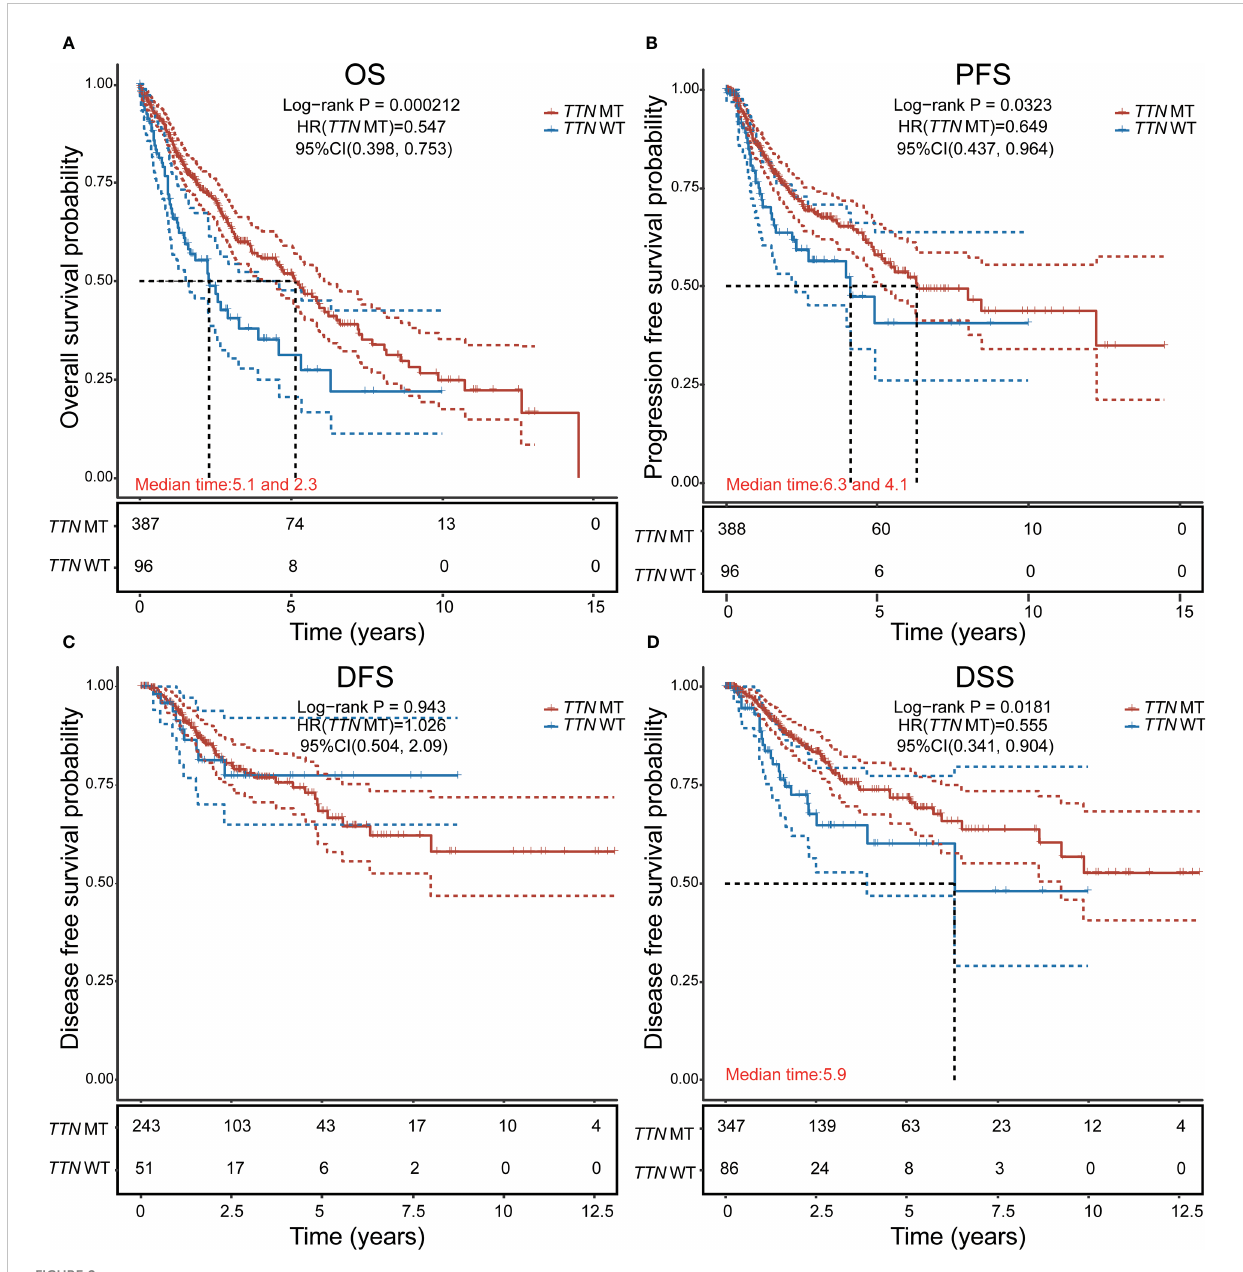
FIGURE 2 Analysis of the effect of TTN mutation on prognostic survival in LUSC using the Cox regression model. (A) Overall survival (OS). (B) Progression-free survival (PFS). (C) Disease-free survival (DFS). (D) disease-speci fi c survival (DSS). HR represents the risk coef fi cient of the high-expression group relative to the samples in the low-expression group; 95% CI represents the HR con fi dence interval; Median time represents the survival rate of the two groups (high-expression group and low-expression group) at 50% (i.e., median survival time) corresponding to the time in years; and the test between the two groups was performed by log-rank and was statistically signi fi cant at P <